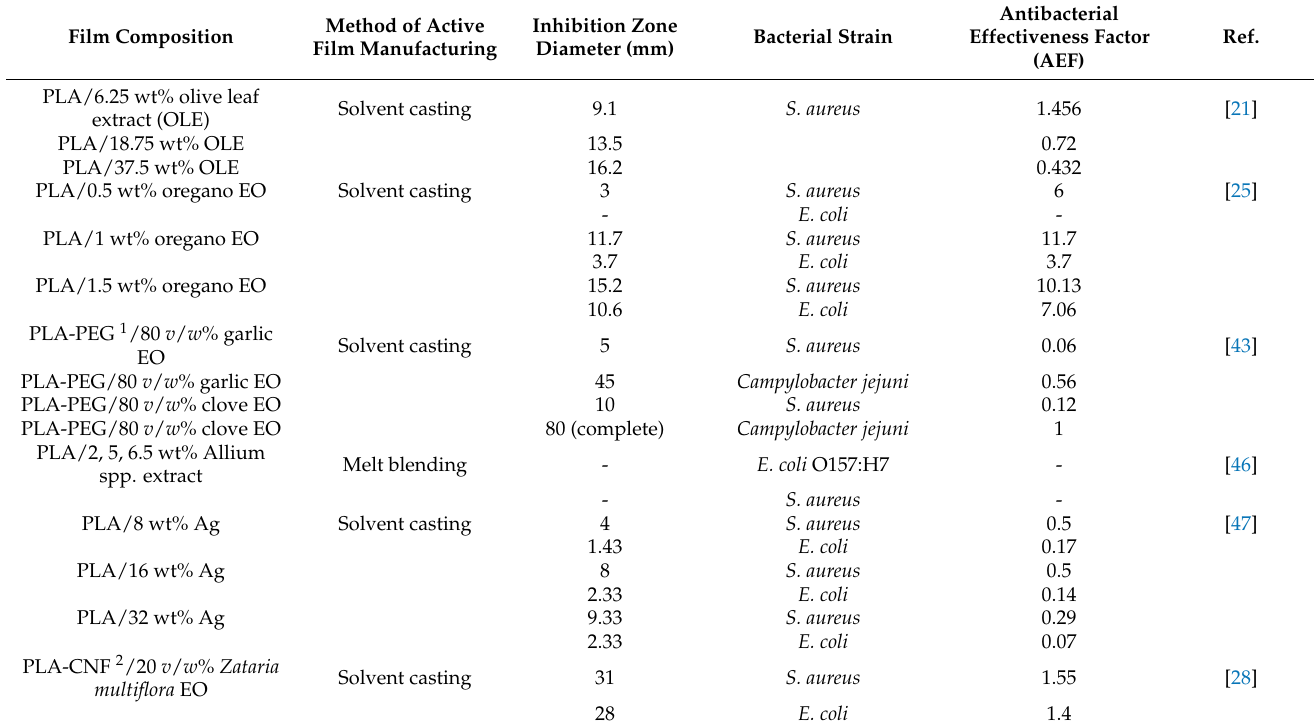
Table 5. Comparison of antibacterial effects of different active poly-lactic acid (PLA) films against common foodborne